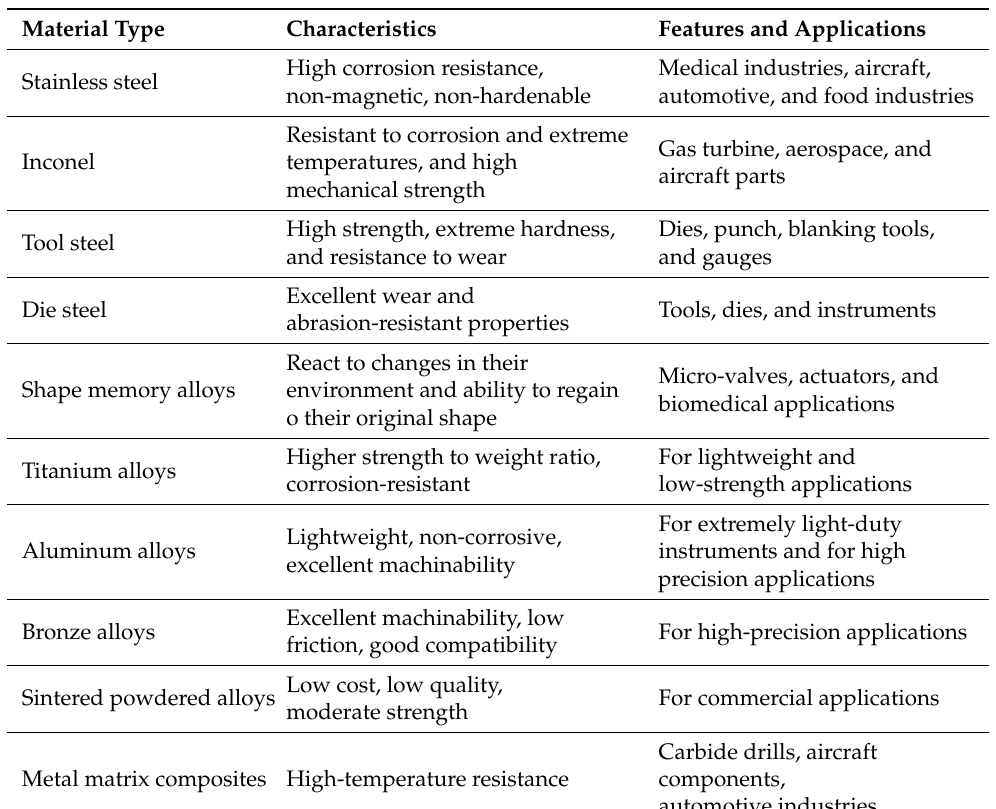
Table 1. Characteristics, features, and applications of different materials used in TET and WTET